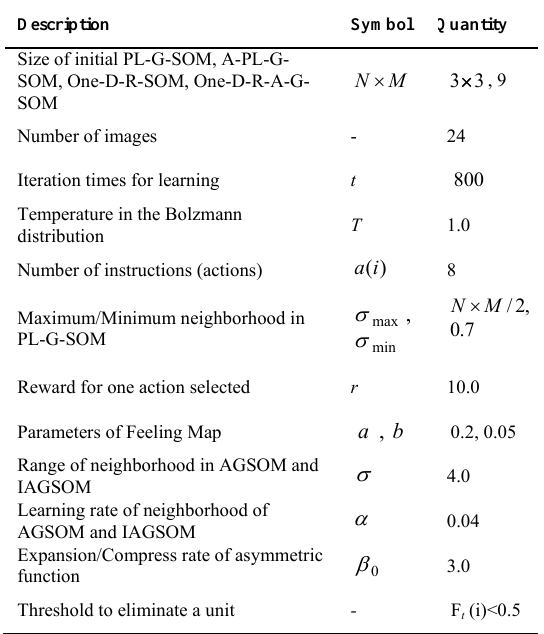
Table 2. Parameters used in the